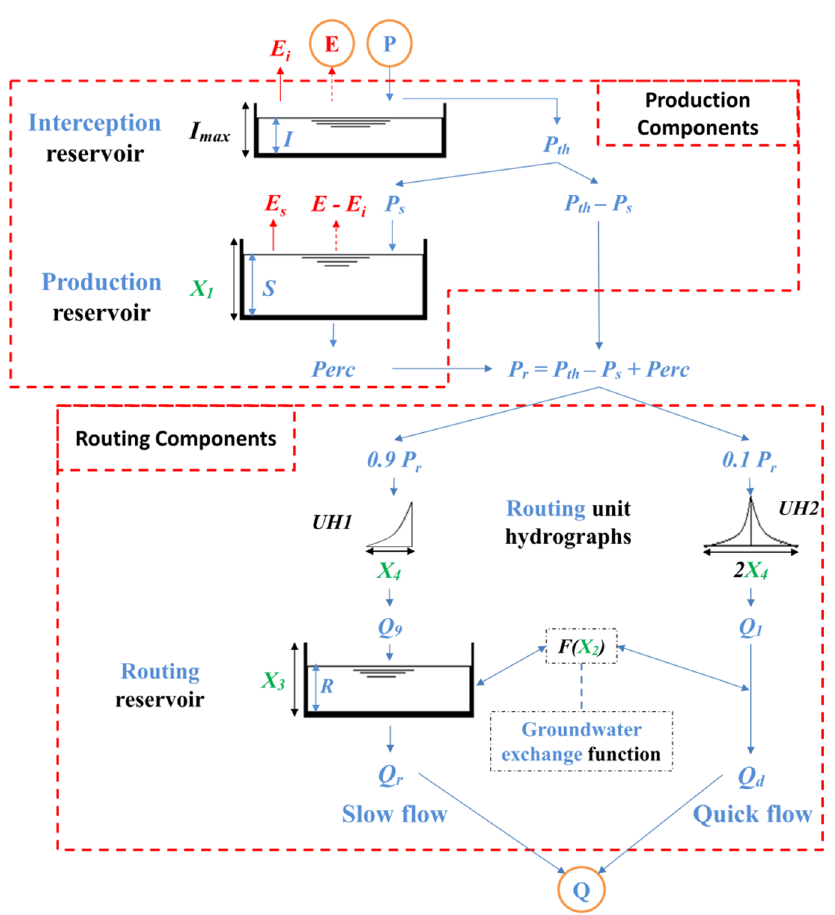
Figure 3. GR4H model structure [85]. The water fluxes are specified in blue and red. The four free model parameters X 1 to X 4 are in green.